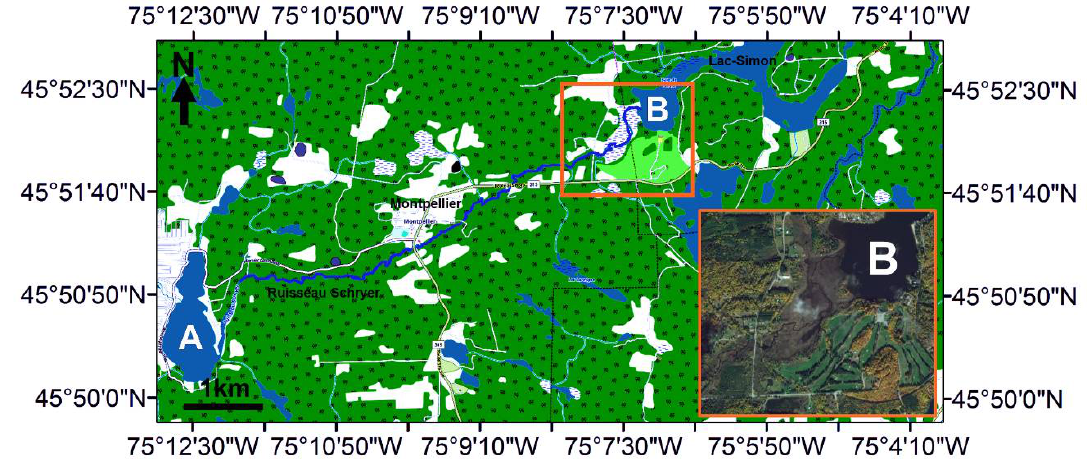
Figure 1. Map of study area showing the town of Montpellier, southern extent of Lac-Simon, and stream (Ruisseau Schryer) flowing from A (Lac-Schryer) to B (Baie-de-l’Ours). Base map is provided by the Quebec Ministry of Energy and Natural Resources (MERN) showing urban areas (white), water (blue), forest (dotted green), low vegetation (tan), golf course (light green), and marshlands (dashed areas). Zoomed in orange box of Google Earth imagery from July 2017 shows a flood plain surrounding the stream entering Lac-Simon at B.